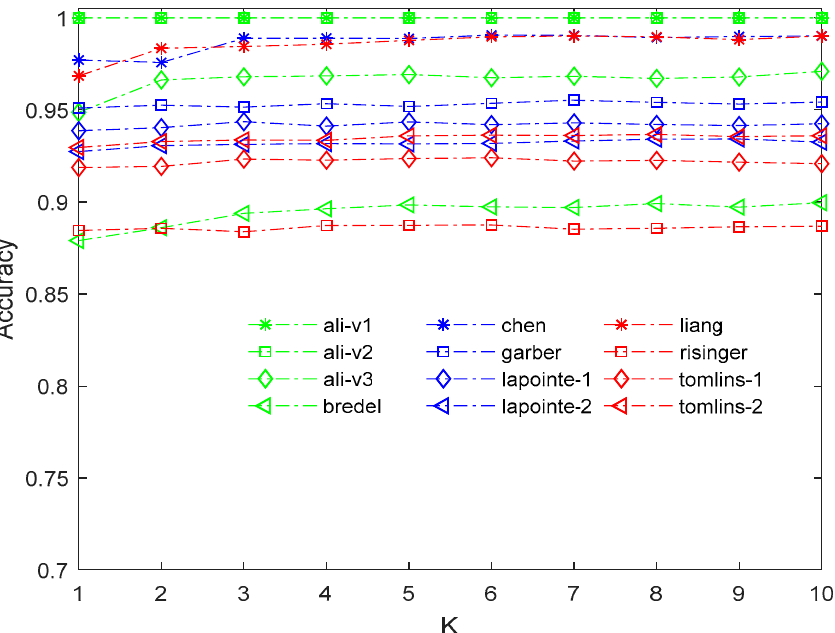
Figure 1. Relationship between FB-MCFS performance and threshold k of mean imputation.